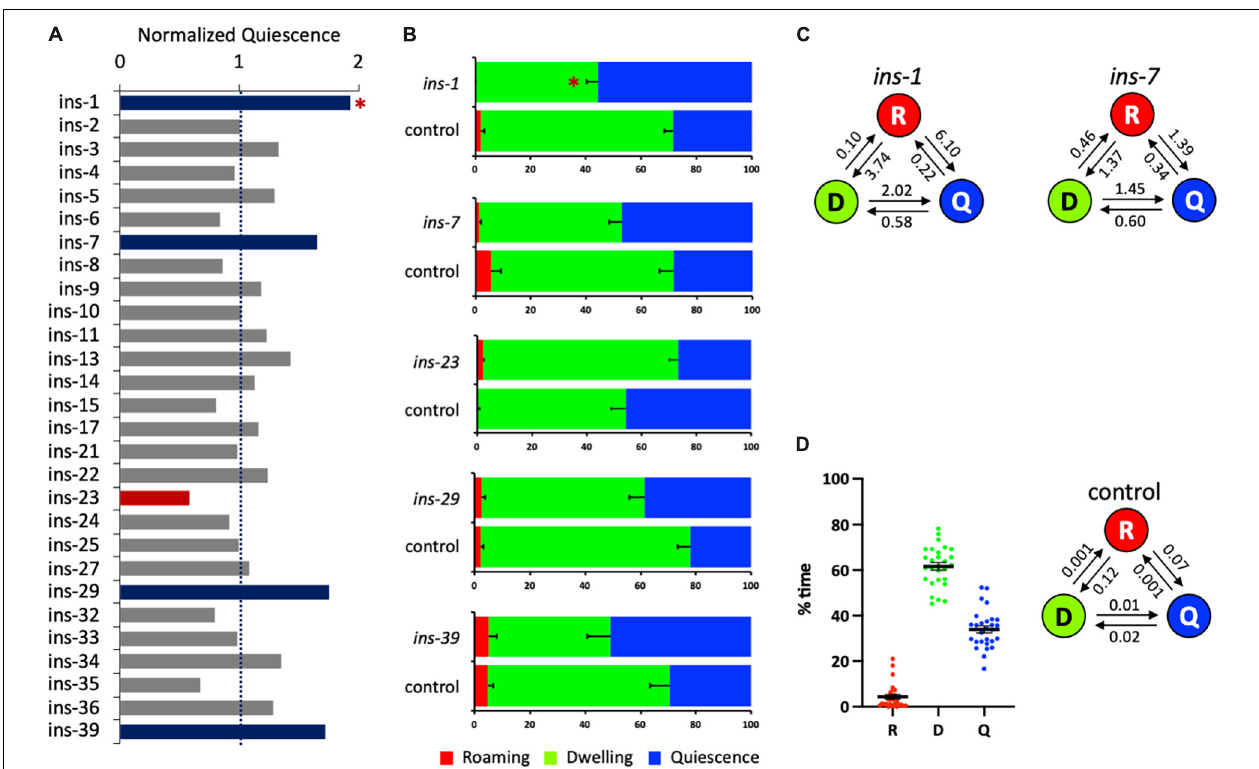
FIGURE 3 | Several ins genes regulate satiety quiescence. (A) The normalized time in quiescence after knockdown of individual ins gene by RNA interference. The percent time in quiescence of each ins is normalized to the percent time in quiescence of the concurrent control (RNAi vector only). Each RNAi was performed with the sample number of 15–18 of tested animals with 7–9 control animals. The experiment was repeated at least three times. Red bars indicate that RNAi of the gene reduced satiety quiescence, whereas blue bars indicate that RNAi of the gene enhanced satiety quiescence. (B) The individual data of the ins genes whose RNAi resulted in changes in satiety quiescence. After two generations of feeding RNAi, the age-synchronized 1-day-old adults were tested for their locomotive activity by measuring the percent time they spent in roaming, dwelling, and quiescence. (C) The transition rates of the animals treated with RNAi of ins-1 and ins-7 . (D) Distribution of the values of each state (left) and average transition rates (right) of the 28 independently tested RNAi control groups. ( ∗ p < 0.009 by Student’s t -test after the Bonferroni correction. The error bars indicate SEM).